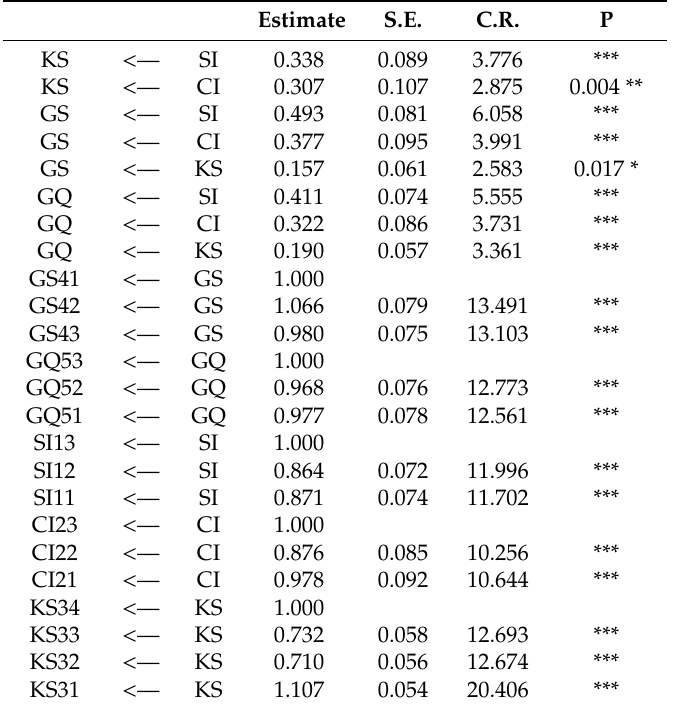
Table 6. Unstandardized regression weights.